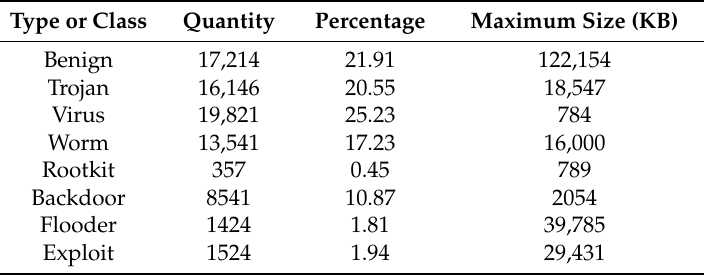
Table 2. Dataset of malware and benign used in our